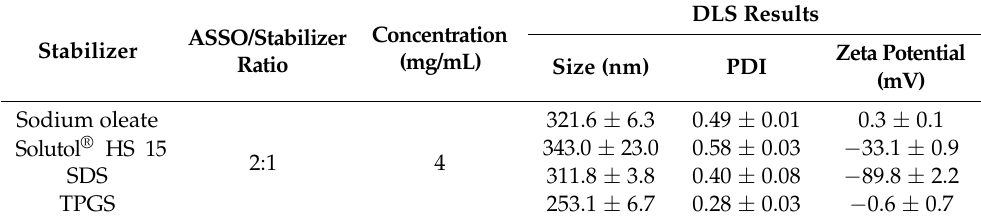
Table 1. Screening suitable stabilizers of ASSO-NPs (mean ± SD, n = 3).